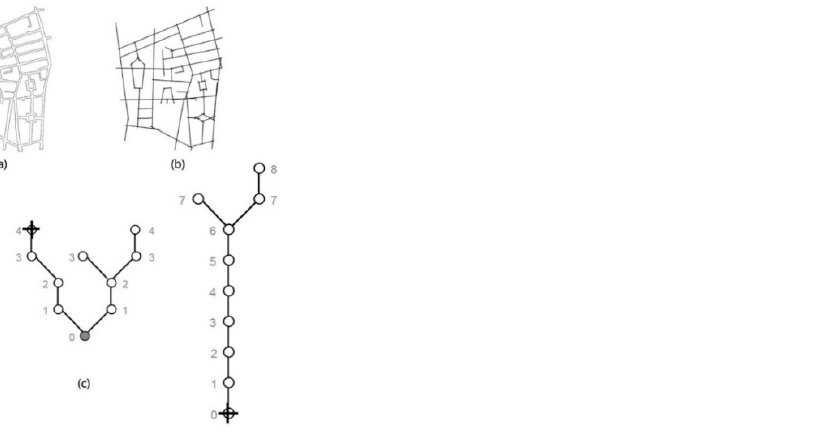
Figure 1. Topological analysis methods of space syntax based on axial lines ( a ), ( b ) with additional consideration of shortest physical paths ( c ). consideration of shortest physical paths ( c